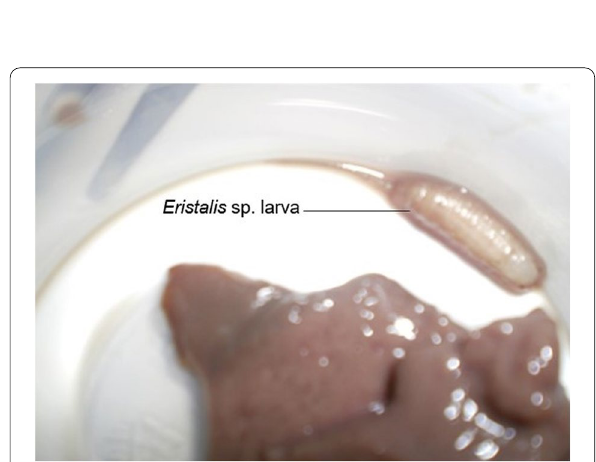
Fig. 2 Eristalis sp. larva collected from case